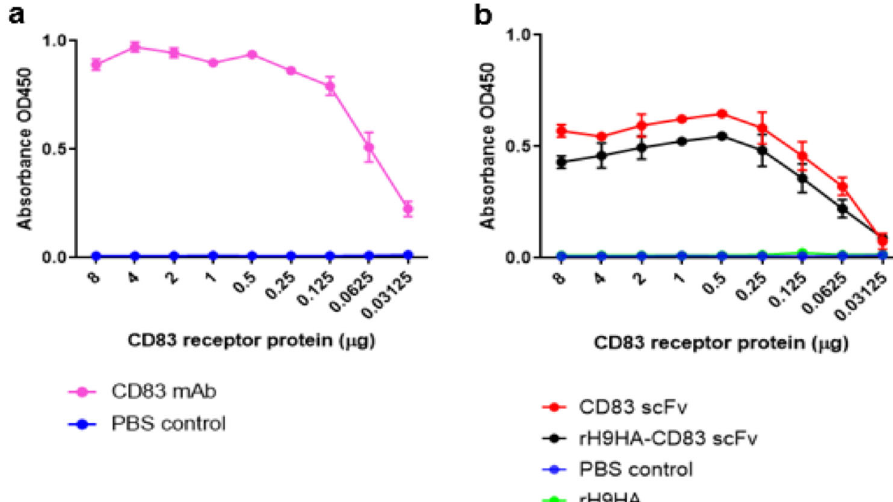
Fig. 3 Characterisation of CD83 scFv and rH9HA-CD83 scFv for binding to chicken CD83 ectodomain using ELISA. a Indirect ELISA for testing the activity of CD83 mAb b Indirect ELISA for testing the activity of CD83 scFv and rH9HA-CD83 scFv. Puri fi ed 8 μ g of chicken CD83 ectodomain was coated onto each well of the ELISA plate, a two-fold serial dilution was carried out and the plate was incubated overnight for 4 °C. For detection, the plates were incubated with an equimolar concentration of puri fi ed CD83 scFv and rH9HA-CD83 scFv or 1 μ g/ml of CD83 mAb. This was followed by incubation with goat anti-mouse HRP secondary antibody for ( a ) and HRP-conjugated anti-V5 secondary antibody for ( b ). The colorimetric detection was carried out by adding TMB substrate and absorbance at 450 nm was